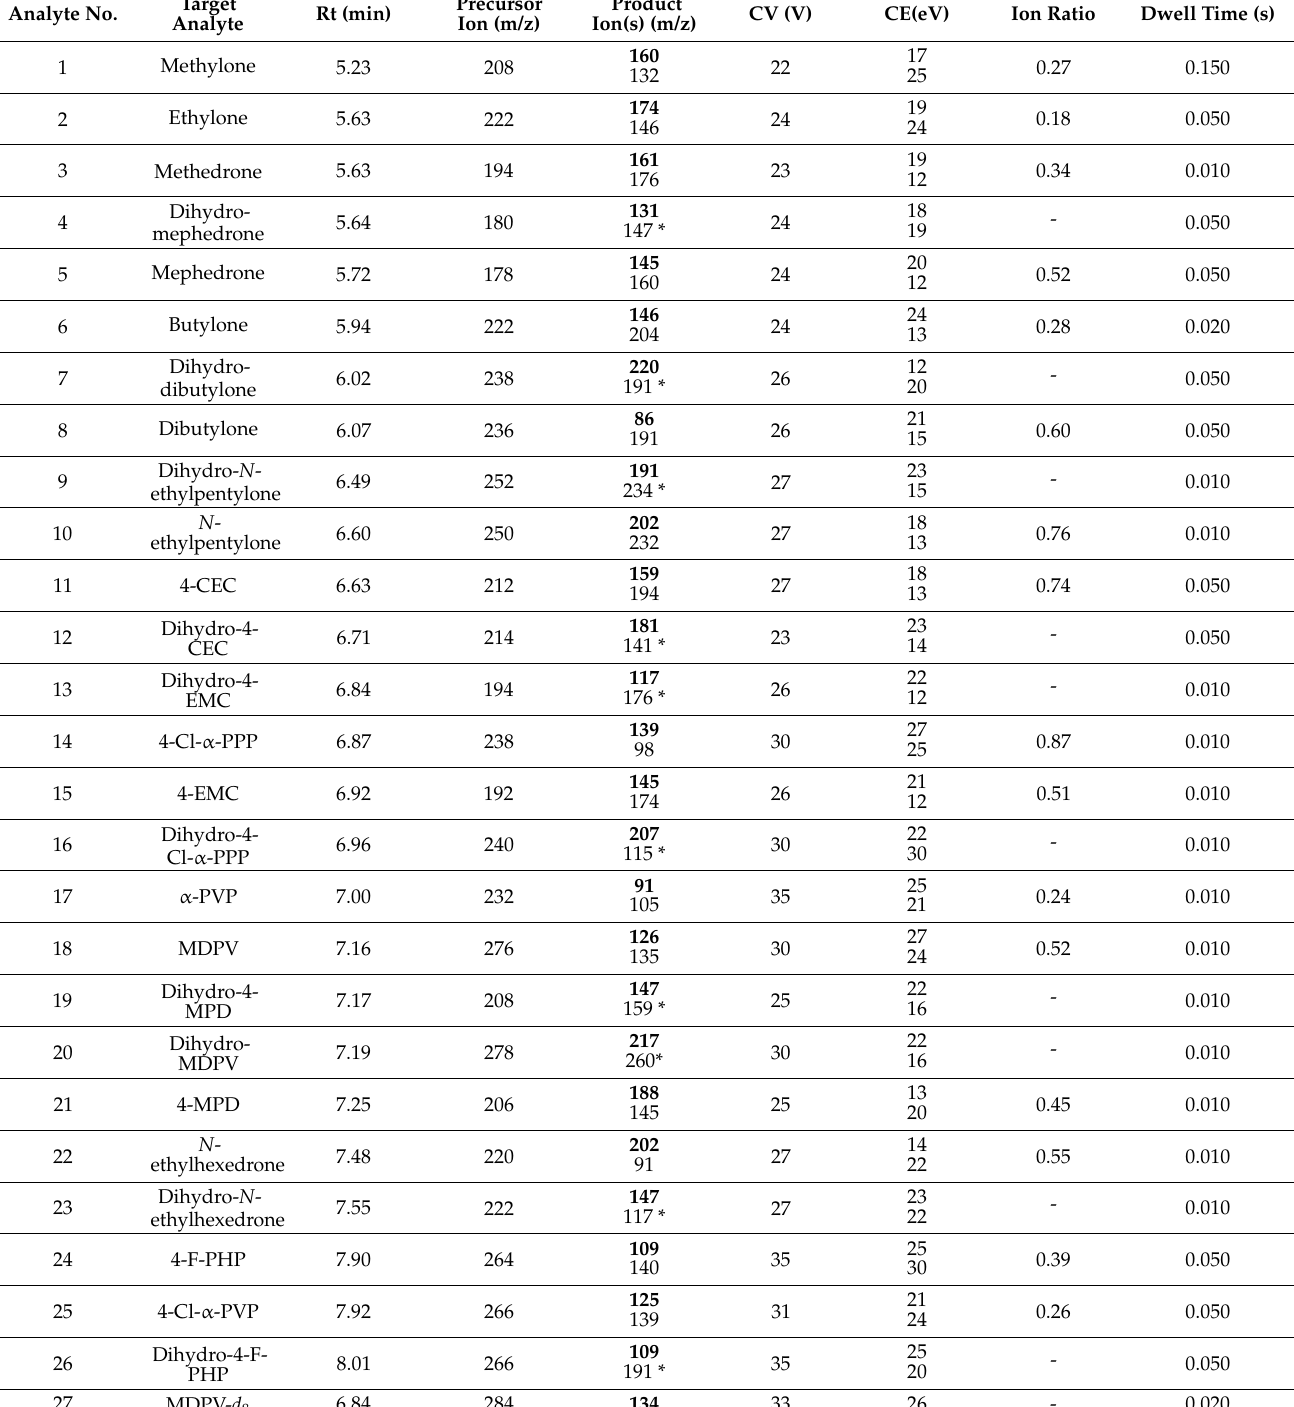
Table 1. Retention time (Rt), precursor ion, product ions (quantifier ions in bold), cone voltage (CV), collision energy (CE) and dwell time for each target